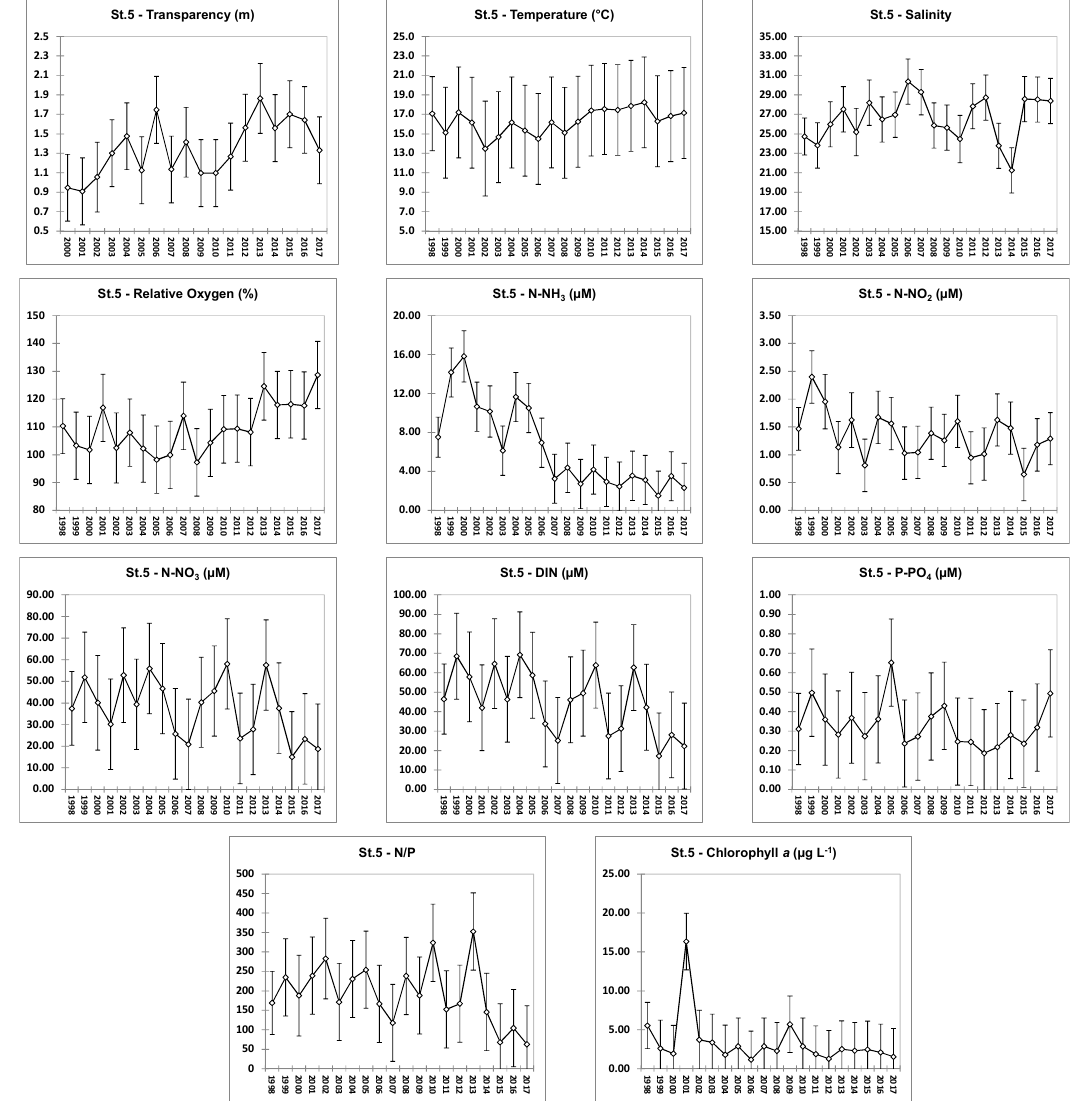
Figure 4. Yearly averages and confidence limits for hydrochemical parameters at St.5. Lower and upper bounds of means (95%) are shown.